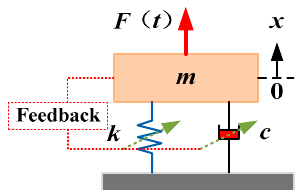
Figure 4. Typical schematic diagram of an active vibration isolation system.